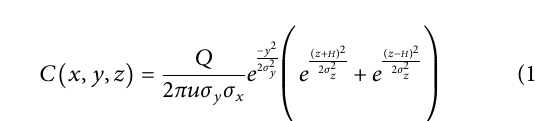
Frontiers in Earth Science |